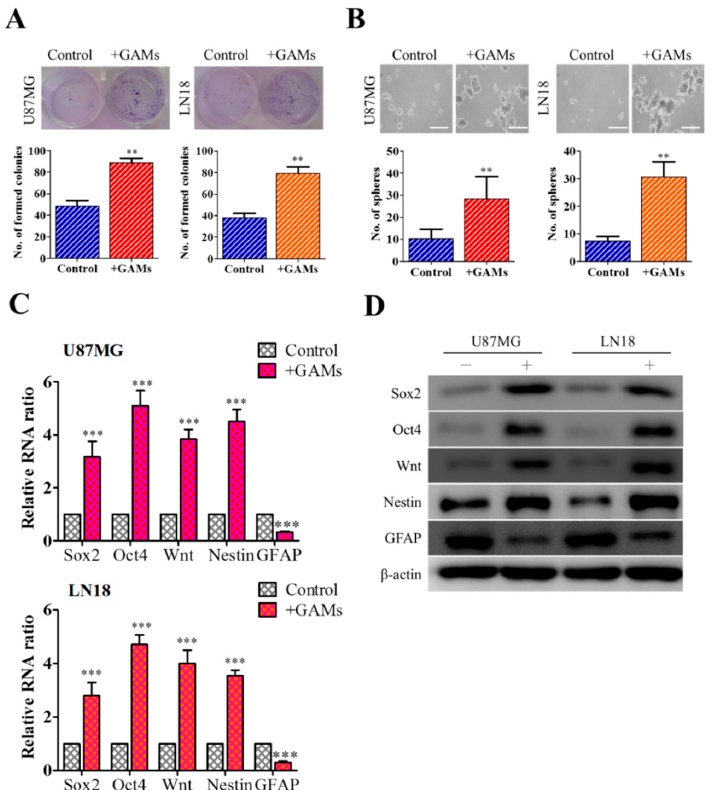
Figure 1. M2 glioblastoma multiforme (GBM)-associated macrophages (GAMs) promote GBM tumorigenesis. GBM cells U87MG and LN18 cocultured with M2 GAMs showed significantly increased colony forming ability ( A ) and tumor sphere generating ability ( B ) as compared to their parental controls. Comparative real-time PCR ( C ) and Western blots ( D ) showed that M2 GAM cocultured GBM cells expressed a significantly higher level of stemness markers, Sox2, Oct4, Wnt, and Nestin while GFAP was reduced. Scale lengths = 100 μ m, * p < 0.05; ** p < 0.01; *** p < 0.001.